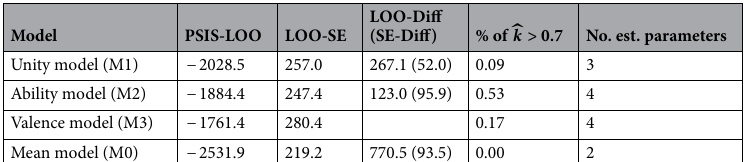
Table 1. PSIS-LOO scores for the whole sample. LOO = sum PSIS-LOO, approximate leave-one-out cross- validation (LOO) using Pareto-smoothed importance sampling (PSIS); LOO-SE = Standard error of PSIS-LOO; LOO-Diff (SE-Diff) = Difference in expected predictive accuracy (PSIS-LOO) for all models from the model with the highest PSIS-LOO (Valence Model) and standard errors of differences; percentage of shape parameters of the generalized Pareto distribution—exceeding 0.7 (all according to Vehtari et al. 60 ); No. Est. Parameters = number of estimated parameters in the